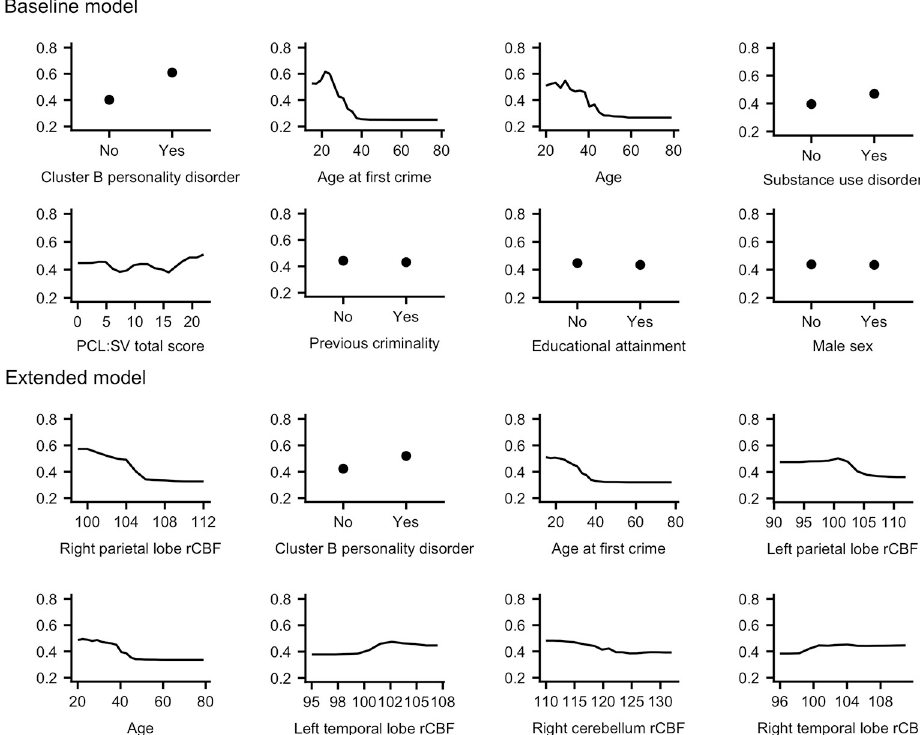
Fig 3. Partial dependence plots. Partial dependence plots for the eight most important (in terms of scaled mean decrease in accuracy) variables in each model. A higher value on the y-axis confers a higher probability of being predicted as a recidivist for the corresponding value on the x-axis for that